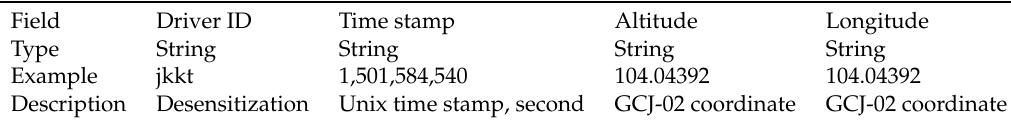
Table 1. The data format of each traffic data item